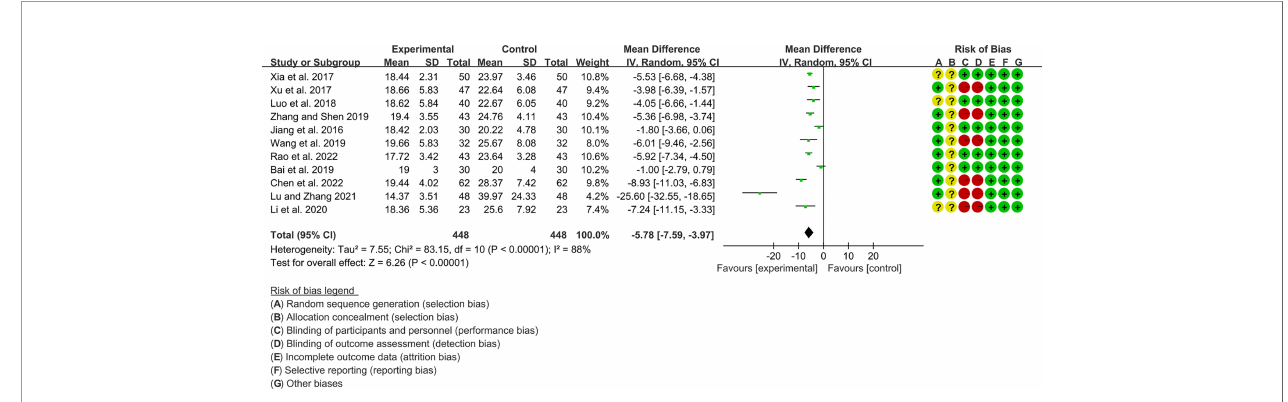
FIGURE 9 | The results of